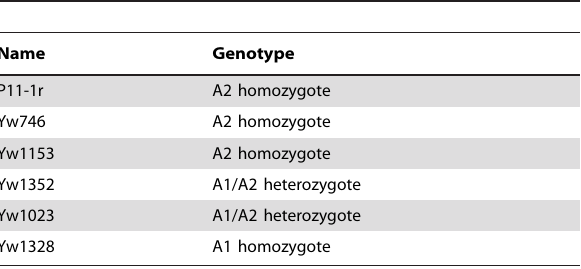
Table 3. Segregation of the A1 and A2 intron